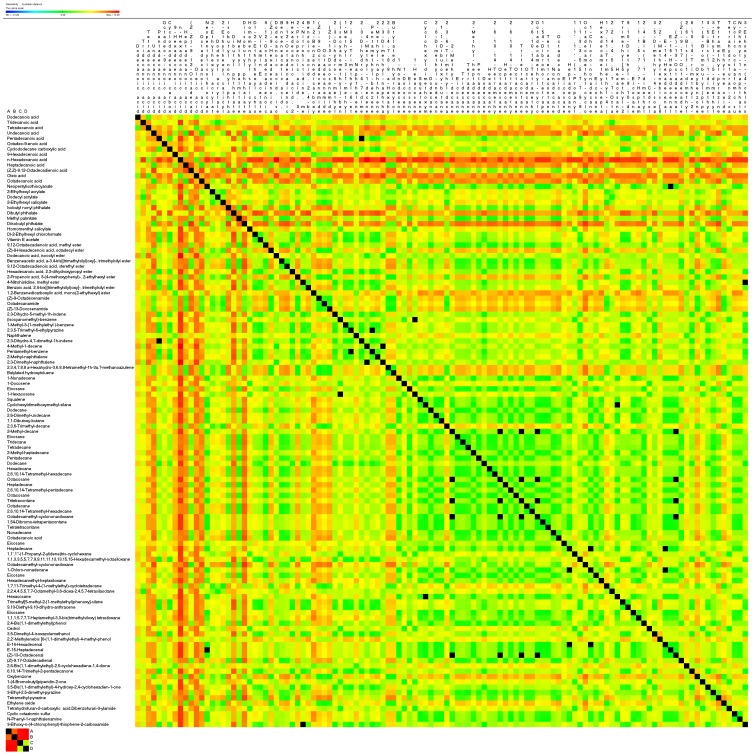
Heatmap of the correlation matrix of the volatile oil that detected in four kinds of materials.Positive correlations are shown in red; negative correlations in green; absence of correlation in black.